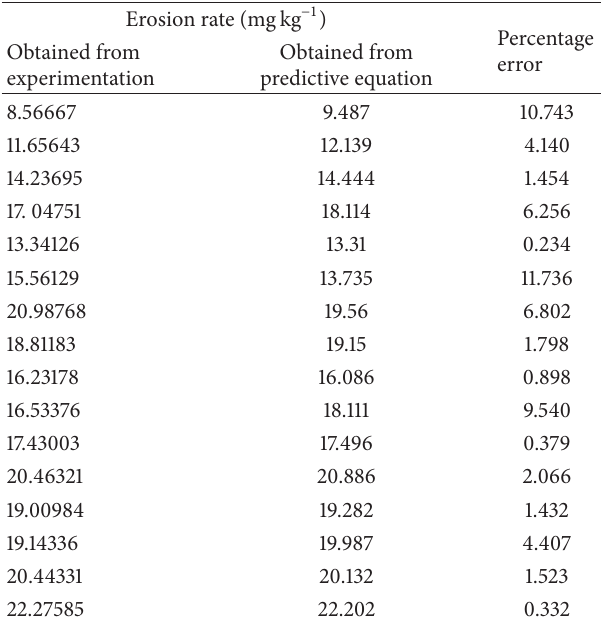
Table 9: Comparison between experimental and predicted values for erosion